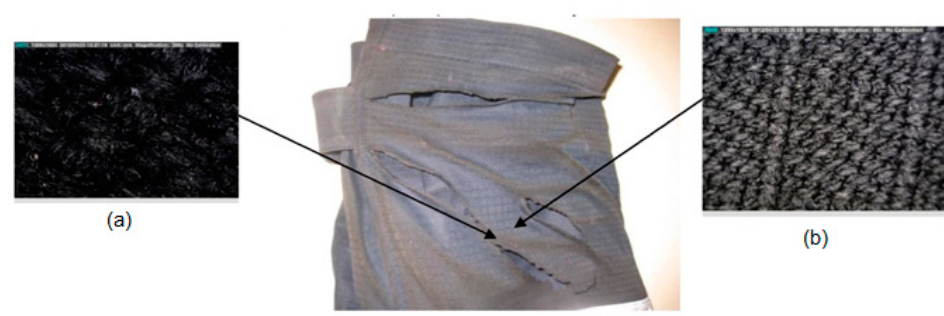
Figure 9. Damage to the sleeve of the overalls made with a Dino-Lite microscope in two different magnification: ( a ) 184×; ( b ) 60×. Damage to the left leg of the overalls (lower leg area) also occurred during the removal of the overalls from the manikin due to the solidification and charring of the fibers during the exposure of heat and flame (Figure 10). Due to the solidification of the material and its cracking, during further movement of the user, the material would fall off, and such overalls would not provide adequate protection in further use.